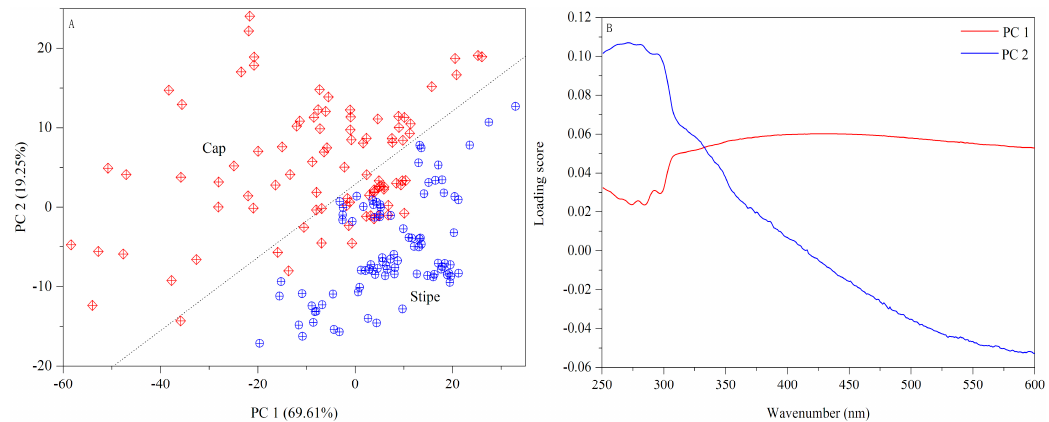
Figure 3. PCA result based on UV-Vis spectra (( A ) Score plot; ( B ) Loading plot).